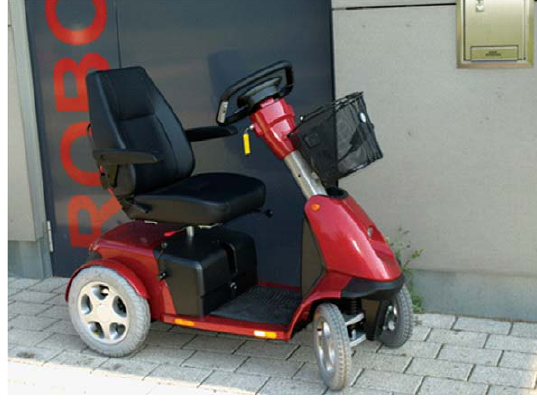
Fig. 2. The basic scooter vehicle.